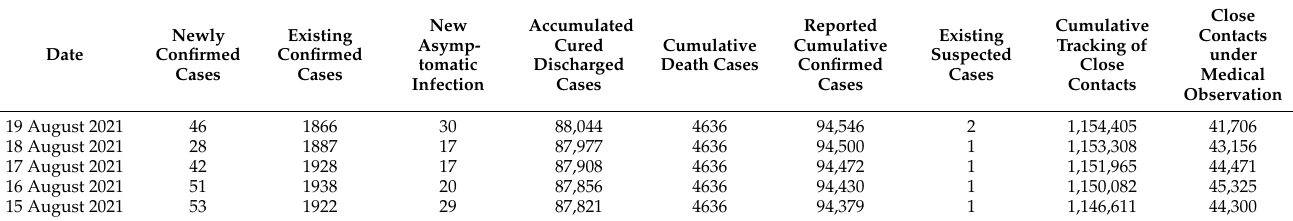
Table 3. Examples of some epidemic